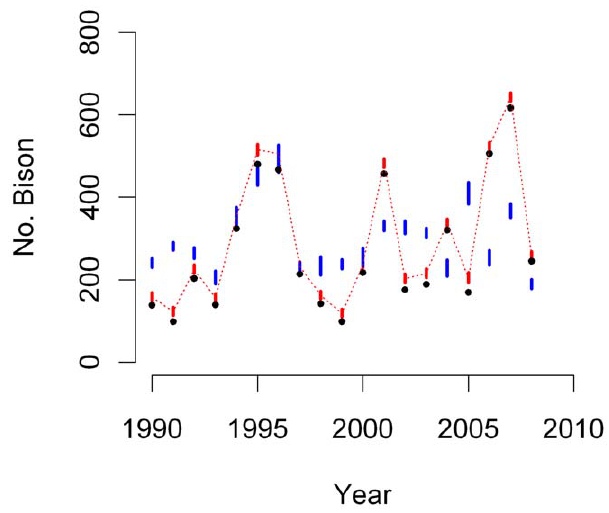
Figure 3. Modified logistic (red) predicted median (dotted lines) and 95% credible intervals (bars) of annual maxima of bison migrating beyond the western boundary of Yellowstone National Park during 1990–2009. Observations (black circles) were precise ( d =0.92) resulting in narrow credible intervals of the vector of true states Z W . We plotted mean process model predictions (blue bars) as p W,t x central to illustrate the relative contribution of process variance and observation